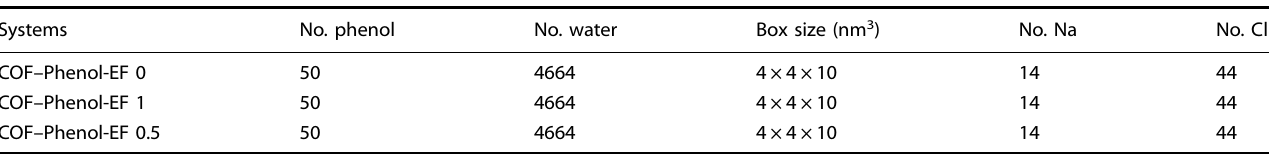
Table 1. Details of the simulation